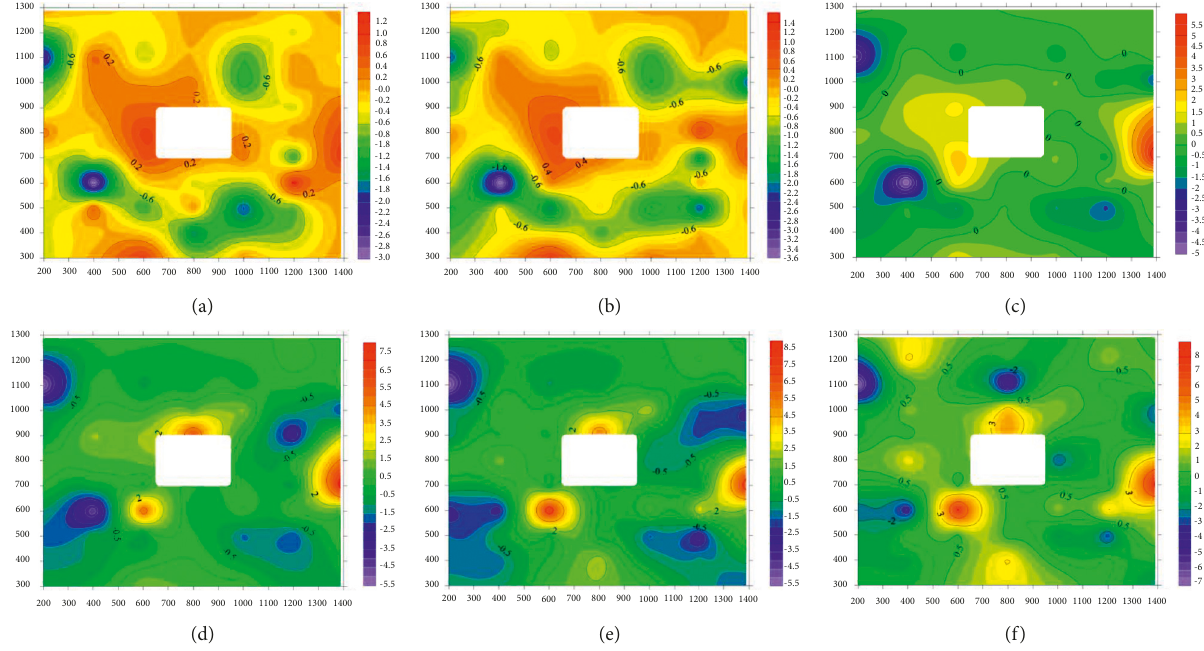
Figure 13: Evolution of vertical stress field under different loads; (a) Under load level 4; (b) Under load level 14; and (c–e) Under load level 23 and cumulative duration is 541mins, 542 mins, 543mins, and 544mins, respectively.